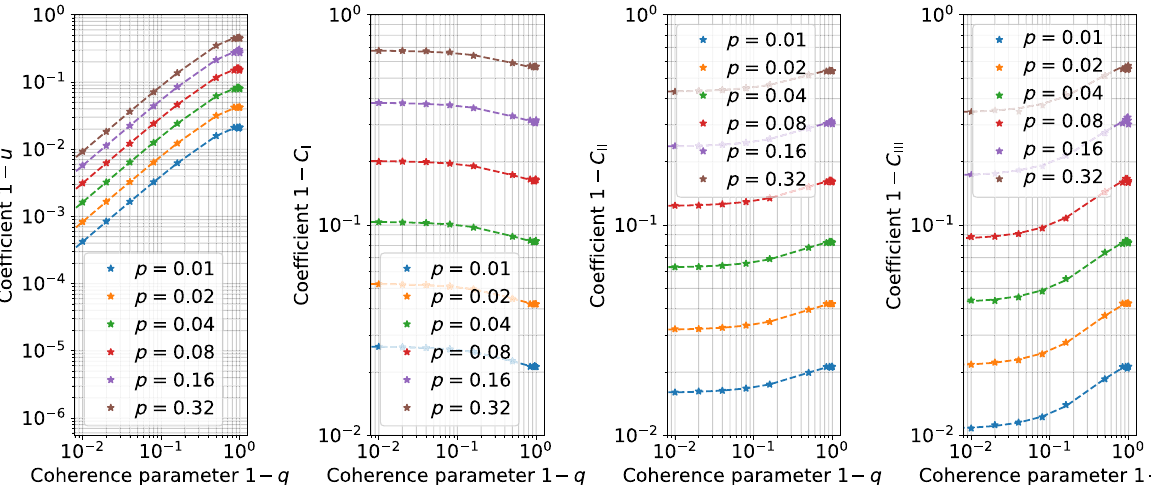
FIG. 3. Four coefficients for exponentially decaying functions in the 2-RB are plotted according to coherence parameter q , where we had 10 4 measurement and 10 4 samplings of unitary sequences. Dashed lines are theoretical values. Each color corresponds to each value of the parameter p